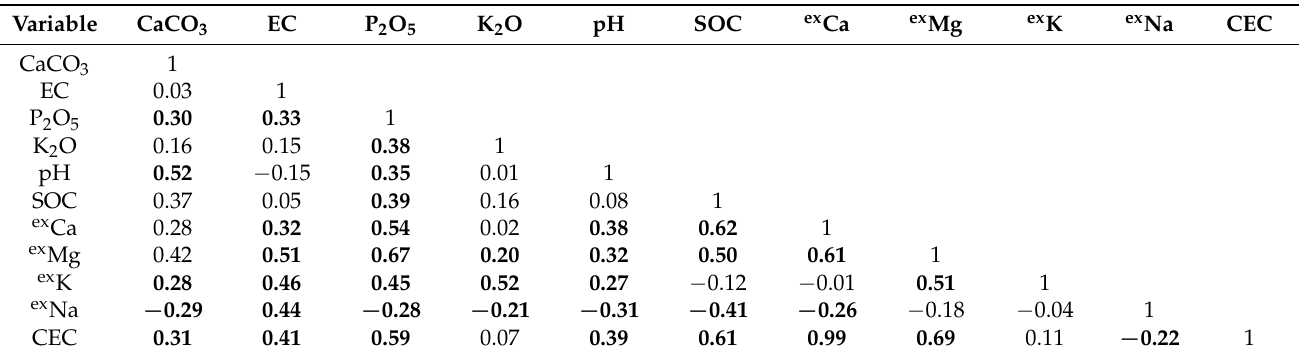
Table 3. Correlation coefficients among eleven soil chemical properties ( n =